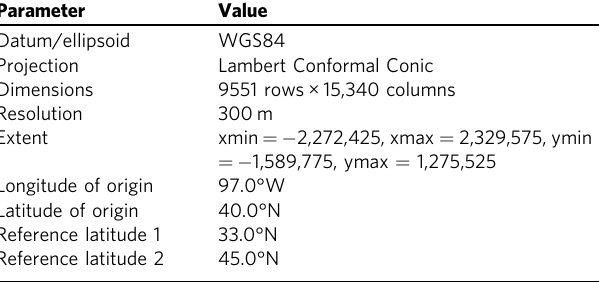
Table 3. The DP shape fi le, containing 28,705 polygon features, each representing a DP entity, was rasterized using ArcGIS into the same 300 m× 300 m Vulcan grid. In rasterizing the DP polygons, each grid cell was assigned a DP identity from the polygon that overlaps the center of the cell (https://pro.arcgis.com/en/pro-app/ tool-reference/conversion/polygon-to-raster.htm). The 300m ×300 m gridded Vulcan output was then aggregated by DP entity to generate the emissions values for the 28,705 DP entities. The caveat of this method is that certain small, localized